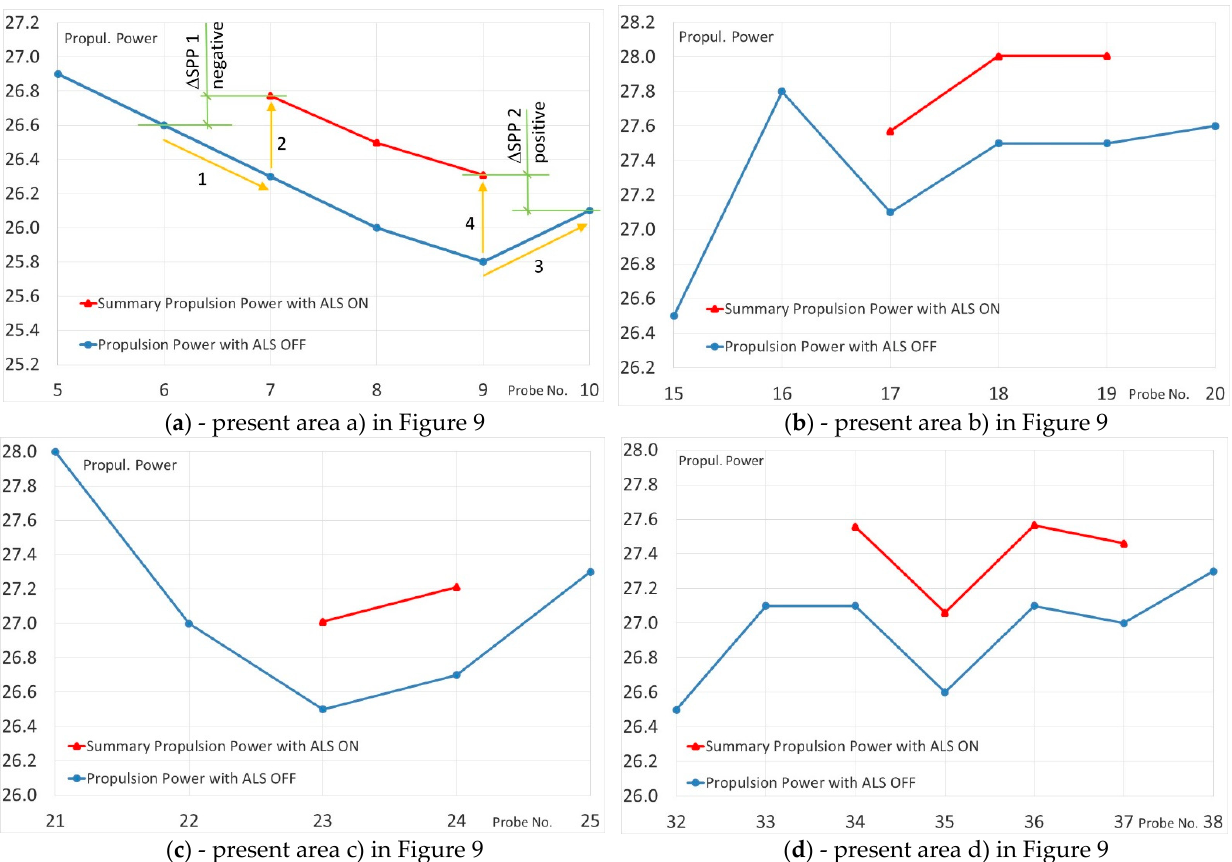
Figure 10. Details of changes in consumption of Propulsion Power and Summary Propulsion Power with ALS (Air Lubrication System) switched ON and ALS switched OFF.